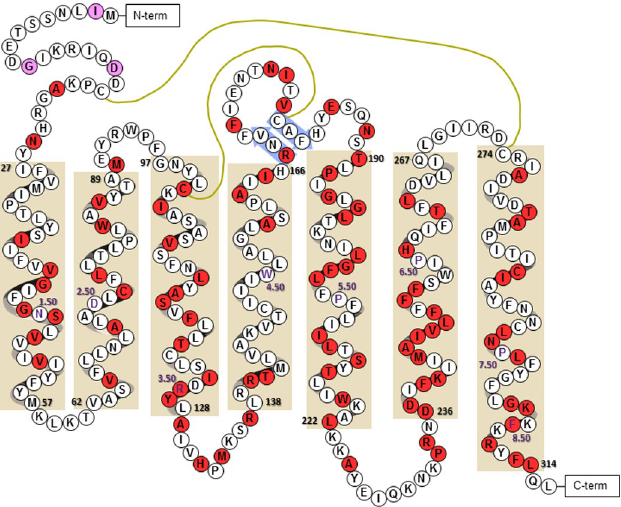
Fig 7. Location of hAT 1 R nsSNPs. A cartoon of the apo-AT 1 R model with alpha helixes depicted within tan boxes, beta sheets depicted within blue arrows, di-sulfide bonds as mustard-colored lines, and residue numbers displaying the residue id of the beginning and end of each helix in black, as well as the Ballesteros-Weinstein numbering of the most conserved residue in purple text. Each polymorphism is shaded pink, if not studied, or red, if examined in this manuscript. The carboxyl unstructured region was not included and contains an additional 15 nsSNPs.